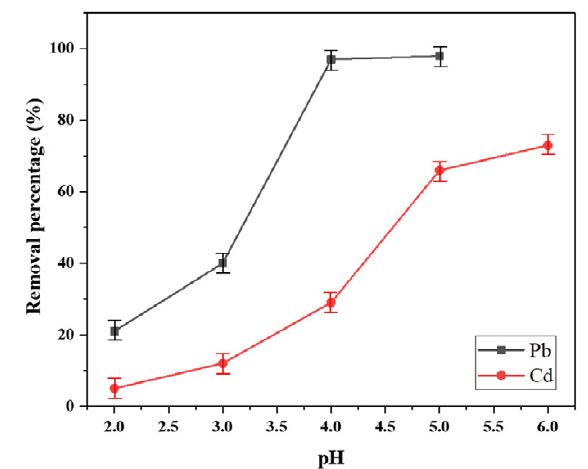
Fig. 6. Effect of pH on the removal percentage (±1.5) of Cd (II) and Pb(II) by pectin/ γ -Fe